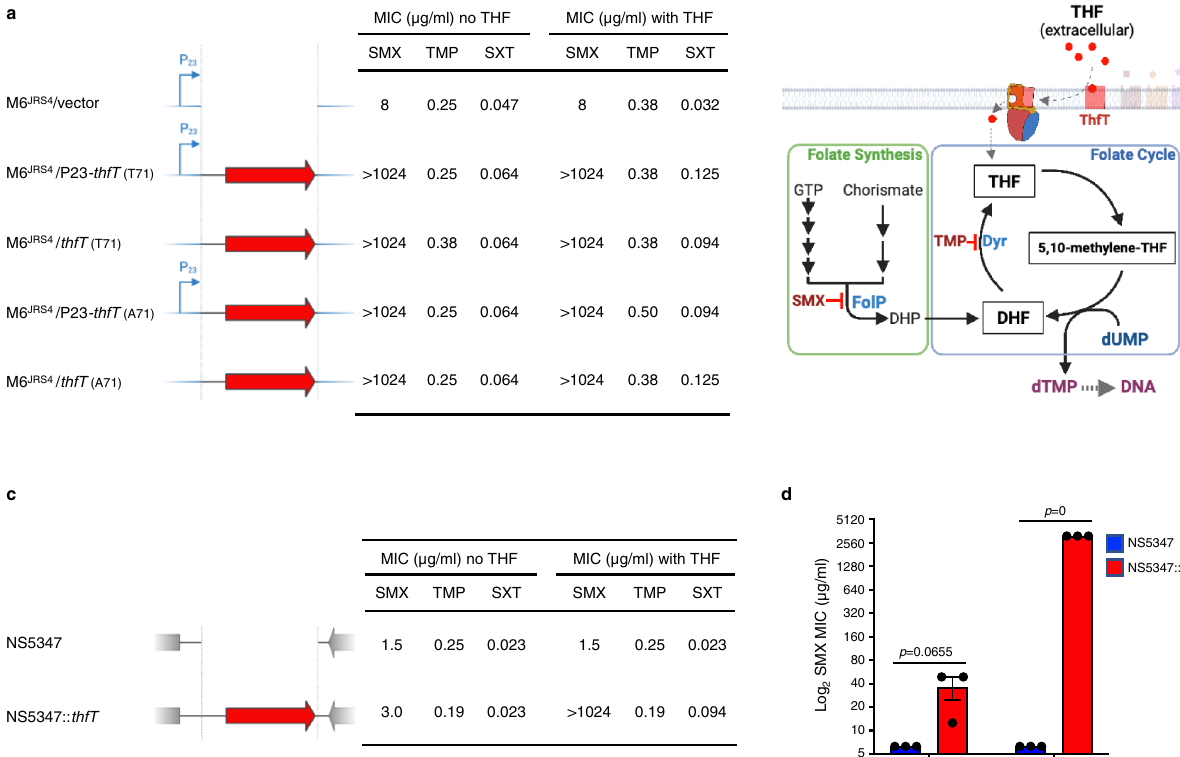
Fig. 4 | ThfTis anSMXresistance proteinthat allowsGAS strains to bypassthe folate synthesis pathway in the presence of exogenous THF. a Heterologous expression of T71 and A71 variants of thfT in M6 JRS4 . The constructs with a con- stitutive P23 promoter are indicated with a blue arrow and thfT is indicated with a redarrow.SMX,TMPandSXTMICsweredeterminedbyEtest.ExogenousTHFwas supplied at a concentration of 50ng/cm 2 . Results are median values of three independentexperimentsdeterminedwithEteststripsonMHF-Bmagar.Statistical analysis of groups is in Supplementary Table 4. b Model of ThfT mediated SMX- resistance. ThfT is able to acquire extracellular THF which then feeds directly into the folate cycle (blue box), which bypasses the inhibitory effect of SMX on folate synthesis (green box).AsTHF isrecycled back to DHF during the folate cycle, only